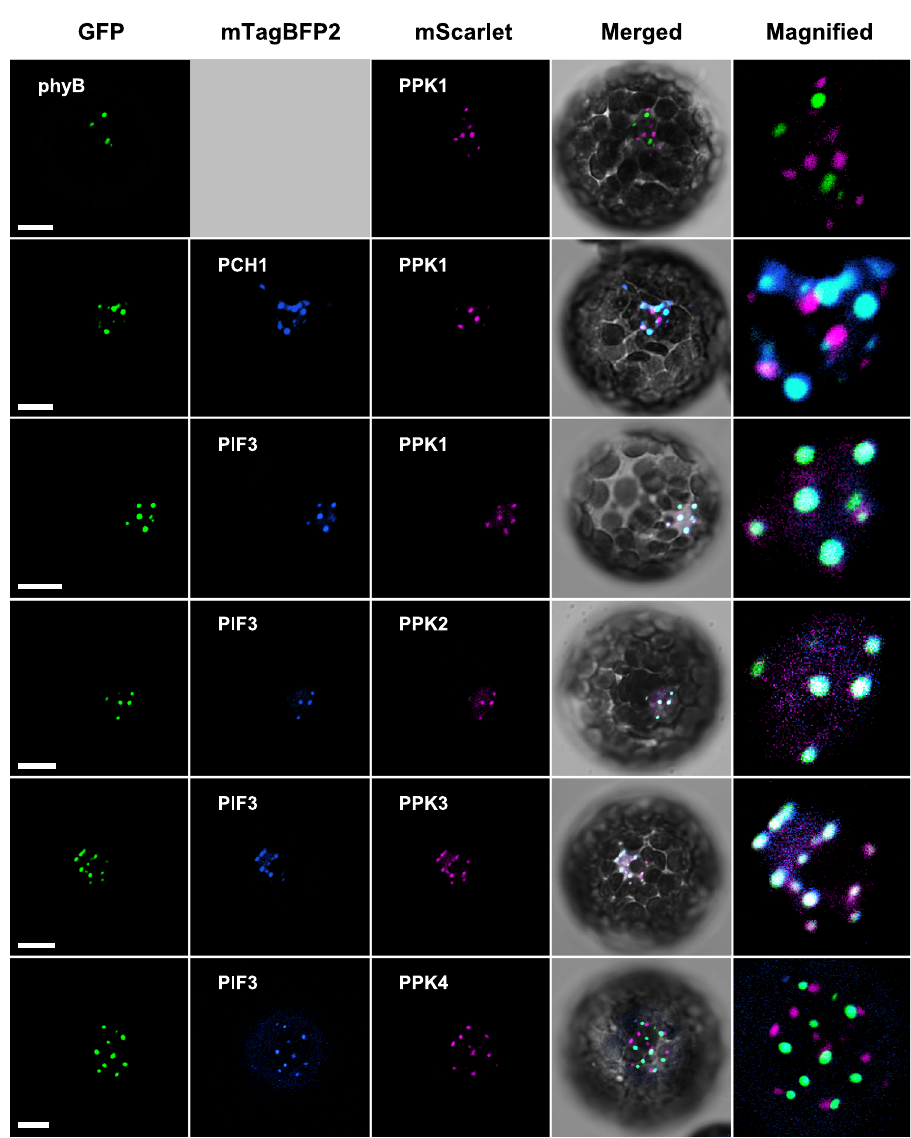
Fig. 5 | PhyB photobody components that localize to the phyB photobody whenco-expressedwithPIF3. mScarlet-fusedPPKsweretransientlyco-expressed withmTagBFP2-fusedPIF3inprotoplasts prepared from PHYB-GFP transgenicline. Images were taken under a confocal microscope using the GFP channel (488nm- 525/25nm) for phyB-GFP (GFP, green color), the BFP channel (405nm-450/25nm) for PCH1- mTagBFP2 (mTagBFP2, blue color), and the RFP channel (561nm-595/ 25nm) for mScarlet-fused proteins (mScarlet, magenta color). The fl uorescence images were either merged with white light images (Merged) or magni fi ed